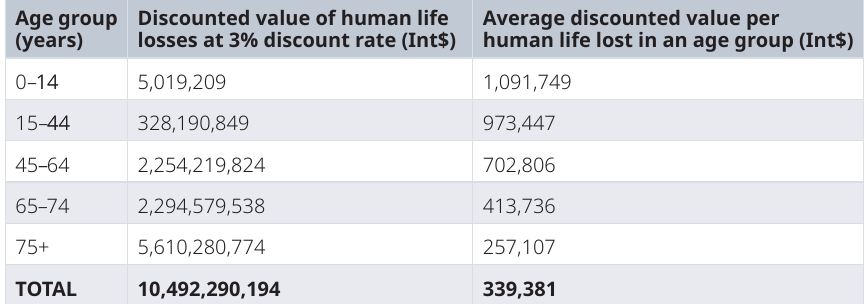
Table 7. Discounted value of human life losses linked to COVID-19 in France, using the national average life expectancy of 83.13 years and a discount rate of 3% (in 2020